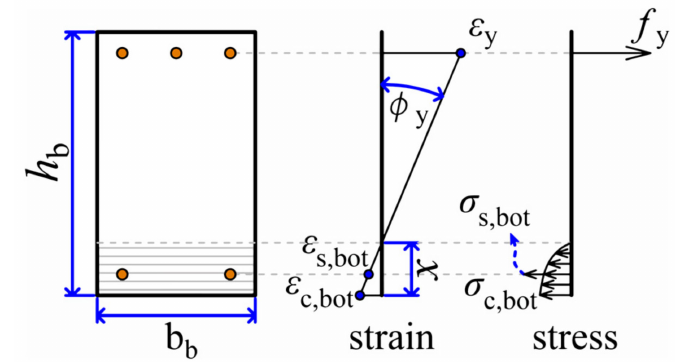
Figure 3. Stress and strain diagram of beam section when yielding.